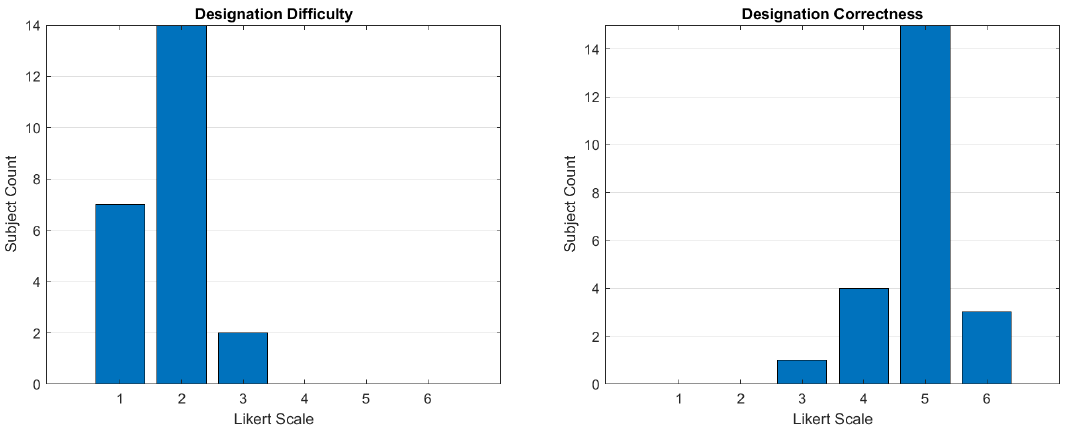
Figure 16. Results of the post-experiment subjective ratings. Left : “What is the difficulty level of designate the targets? (1 = very easy, 6 = very hard)”. Right : “What is your impression on the correctness of designating the targets? (1 = significantly wrong, 6 = very